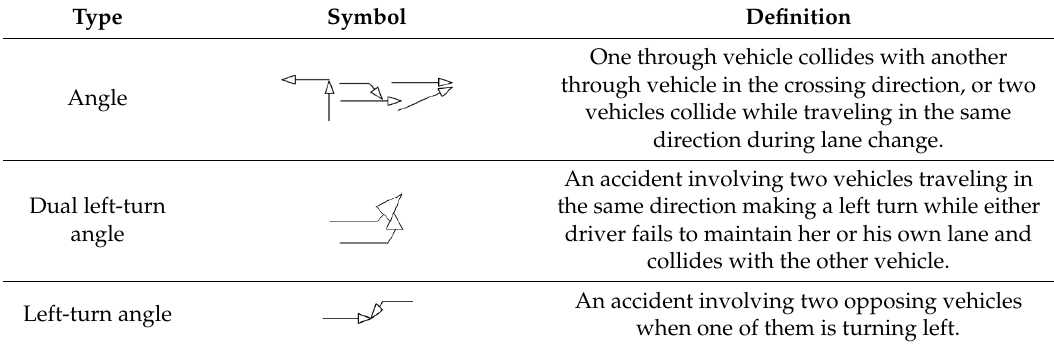
Table 1. Symbols and definitions of types of crashes in the collision diagrams.